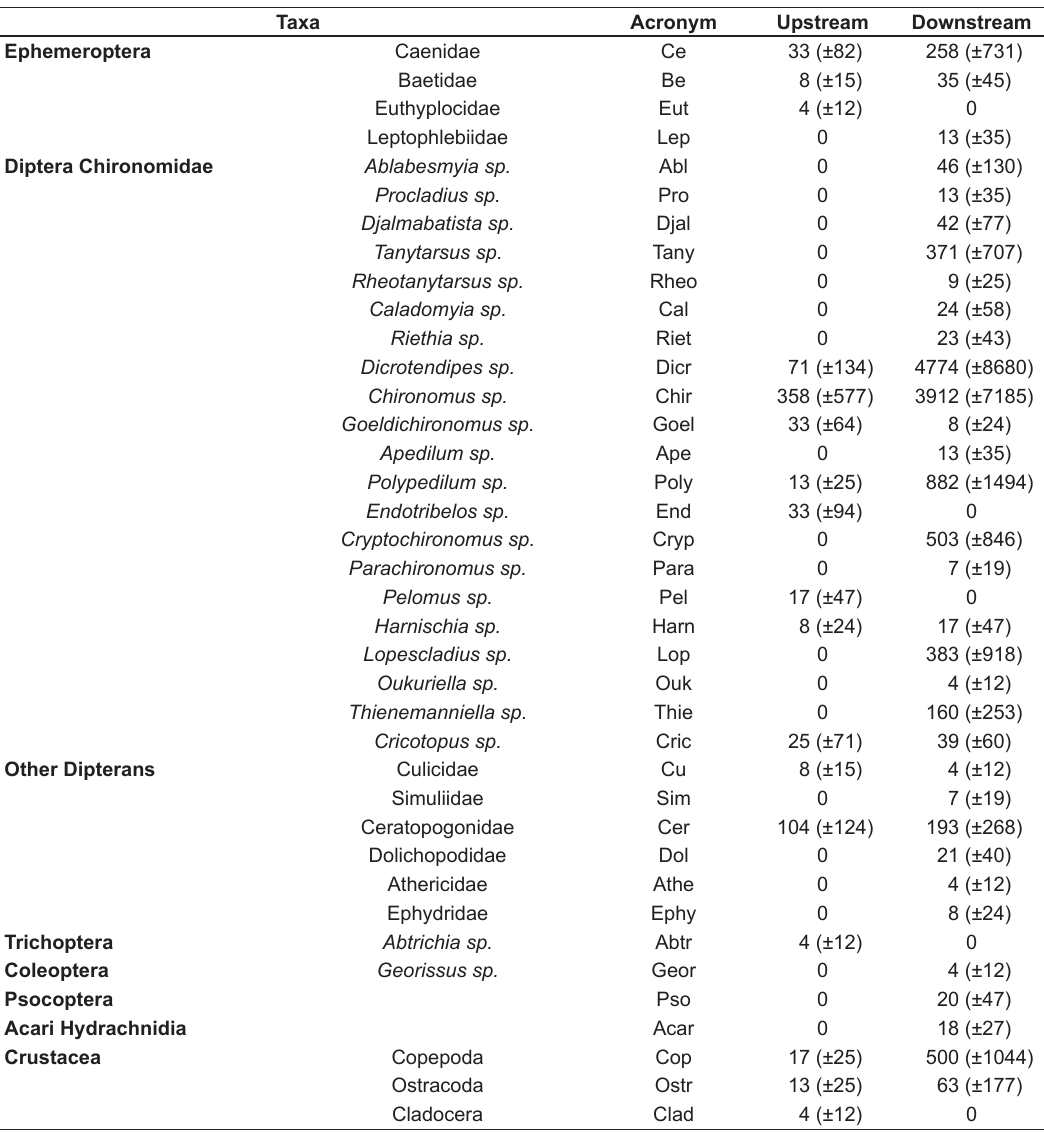
Figure 3. Average density (ind.m -2 ) of macroinvertebrates sampled in each site and the mean discharge (m 3 .s -1 ) corresponding to the previous month to the sampling date. The bars indicate the standard deviation. Table 2. Average of taxa density (ind.m -2 ) ± standard deviation in upstream and downstream